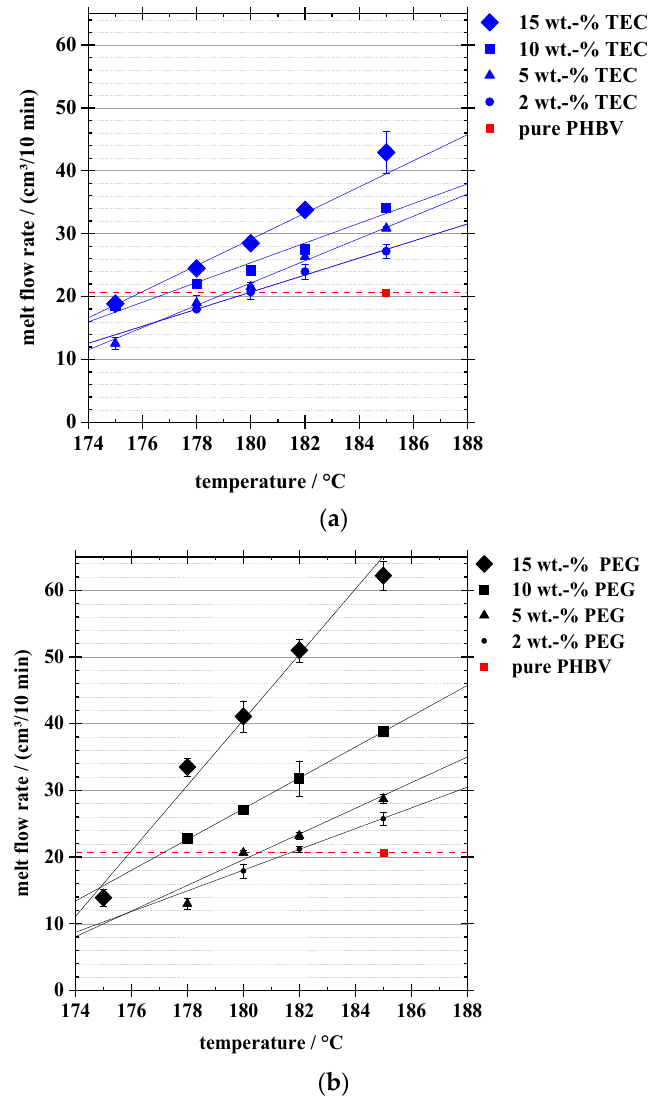
Figure 6. Melt flow rate of PHBV: ( a ) blended with PEG; ( b ) blended with TEC.